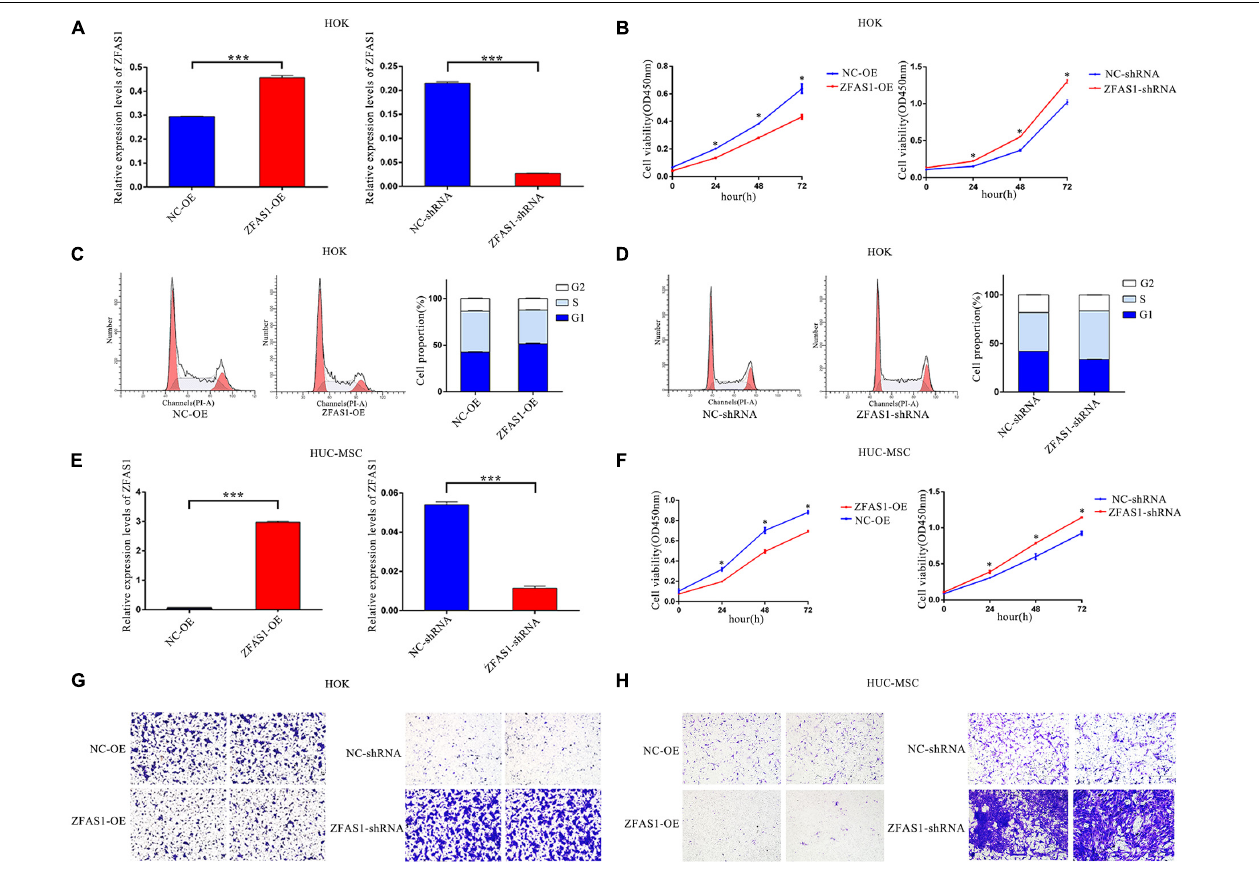
FIGURE 2 | Overexpression of ZFAS1 inhibited cell proliferation and migration in human oral keratinocyte (HOK) cells and human umbilical cord mesenchymal stem cells (HUC-MSCs). (A) ZFAS1 was upregulated and downregulated in HOK cells using overexpression vector of ZFAS1 and shRNA targeting to ZFAS1, respectively. (B) Negative regulation of cell proliferation by ZFAS1 was revealed by Cell Counting Kit-8 (CCK8) assay in HOK cells. (C,D) ZFAS1 overexpression and knockdown in HOK cells increased and decreased G1/S arrest by cell cycle assay, respectively. The two left panels indicate the results from fluorescence-activated cell sorting (FACS), and the right panel indicates the statistical result of the two left panels. (E) ZFAS1 was upregulated and downregulated in HUC-MSCs using overexpression vector of ZFAS1 and shRNA targeting to ZFAS1, respectively. (F) Negative regulation of cell proliferation by ZFAS1 was revealed by CCK8 assay in HUC-MSCs. (G,H) Transwell assays revealed a negative regulation of cell migration by ZFAS1 in HOK cells and HUC-MSCs. Cells were stained with crystal violet. Values are mean ± SEM, n = 3, * P < 0.05, *** P < 0.0001. ShRNA, short hairpin RNAs; OE, overexpression.